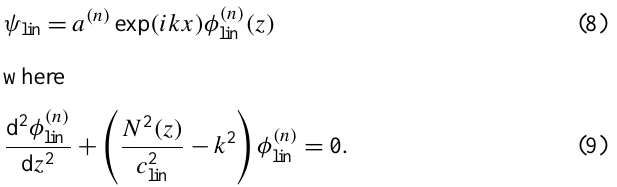
Fig. 2. Contours plot indicating the location of mode 2 wave zeros based on pycnocline centre and width. Note that as the pycnocline is moved away from the centre and thickened, the zero of the mode 2 wave function moves away from the centre of the